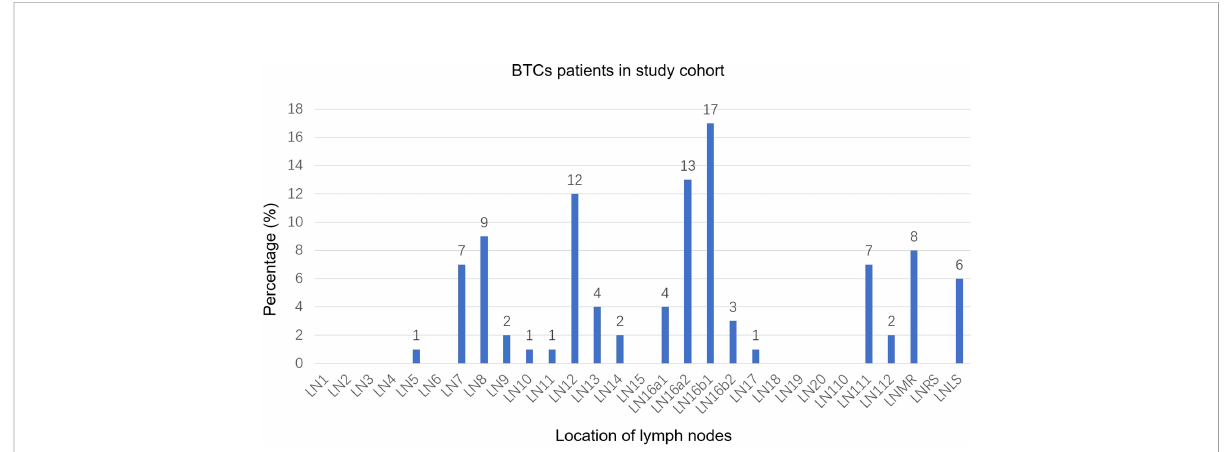
FIGURE 1 Distribution bar plot of positive lymph nodes in the study cohort. BTCs, biliary tract cancer; LN, lymph node; LNMR, mediastinal lymph node; LNRS, right supraclavicular lymph node; LNLS, left supraclavicular lymph node.